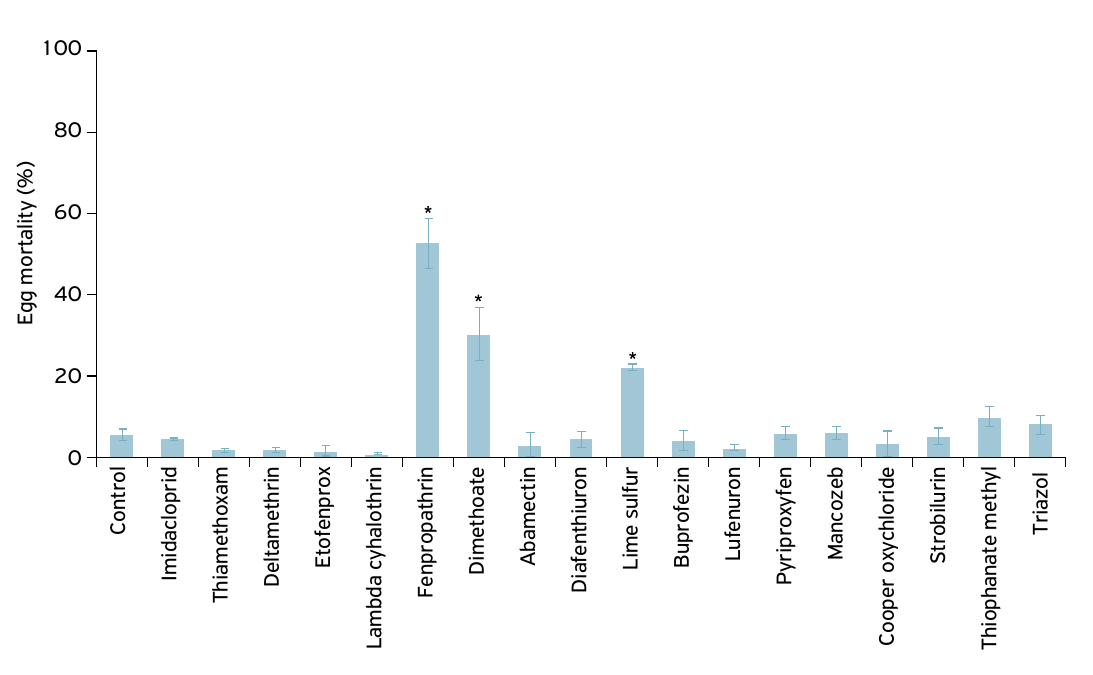
Figure 1. Pesticide effect on the mortality (%) of Panonychus citri adults, 72 h after exposure.